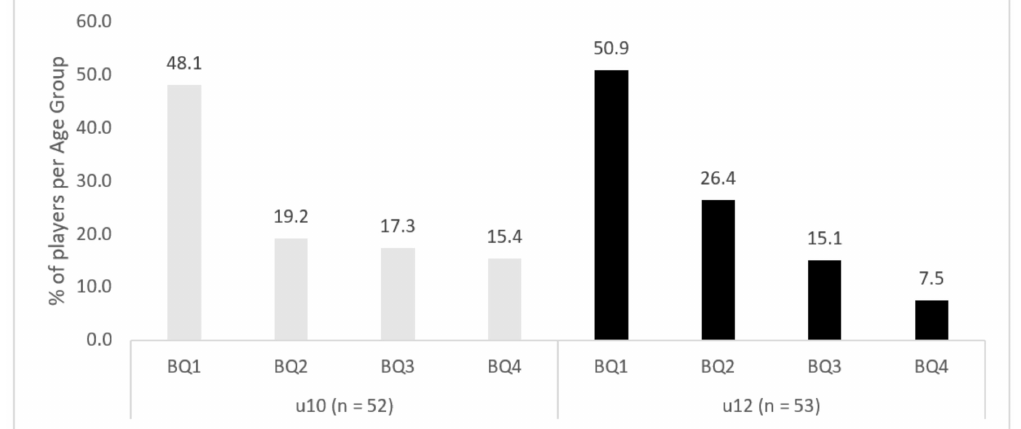
Figure 3. Percentage of players per Birth Quarter (BQ) and Age